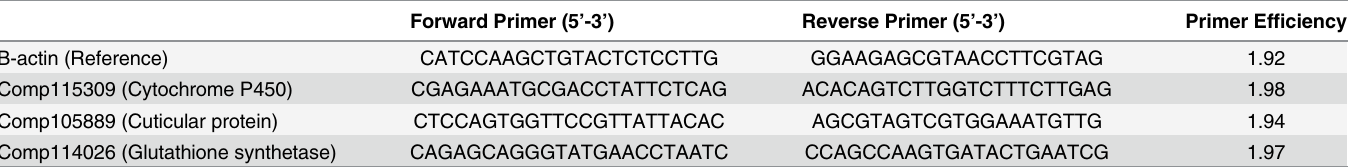
Table 1. qPCR primers and primer